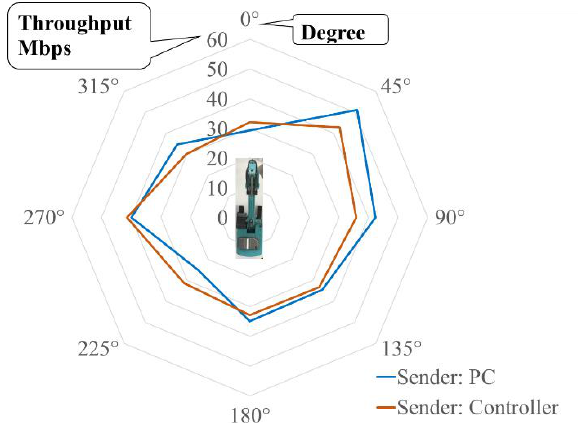
Figure 11. Average TCP throughput in each direction: The blue line is the results when the PC is the sender, and the orange line is the results when the controller is the sender. The communication distance is 10